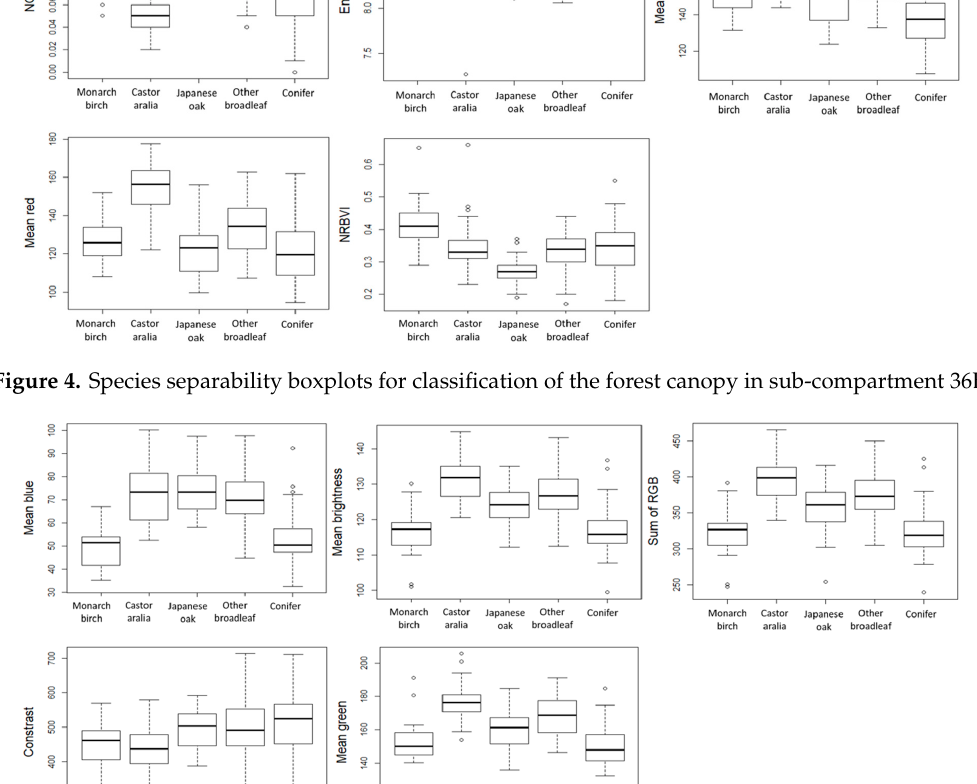
Figure 5. Species separability boxplots for classification of the forest canopy in sub-compartment 59A.